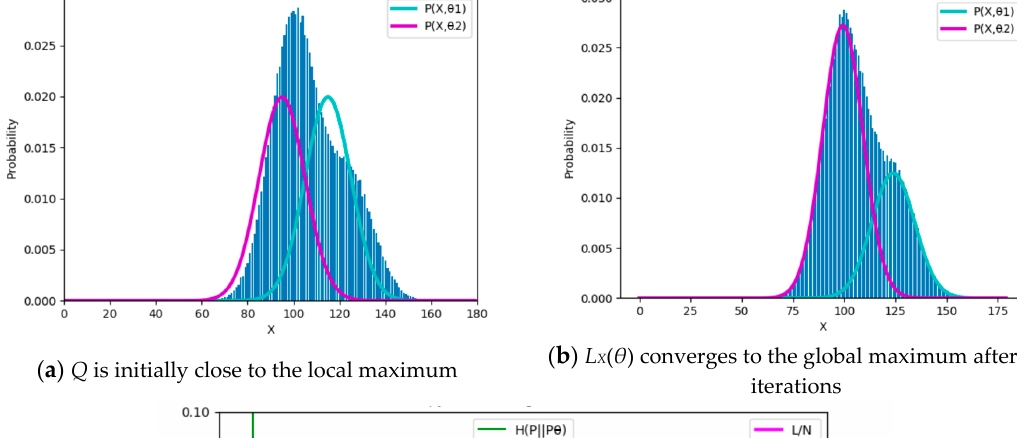
Table 4. True and guessed model parameters and iterative results of Example 6.